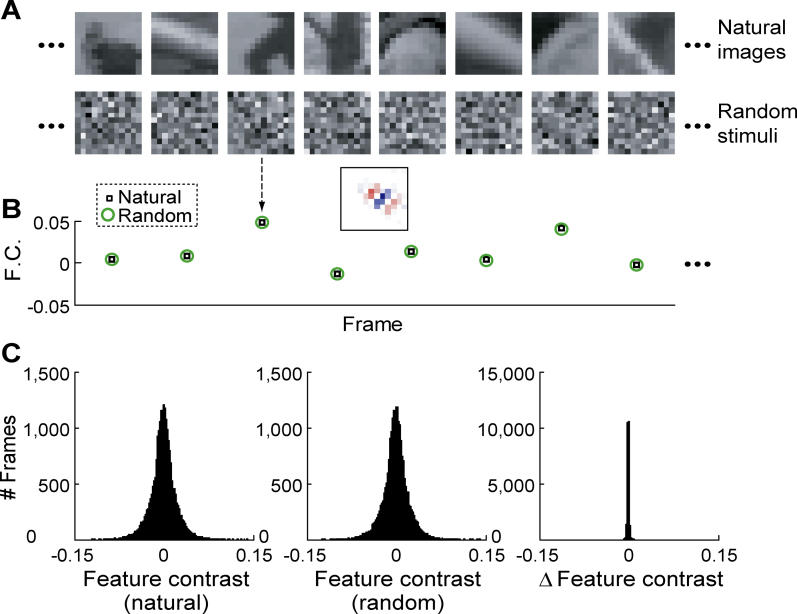
Matching of Feature Contrasts in Natural and Random Ensembles(A) Example images in the natural (upper row) and the random (lower row) ensembles, which were matched frame by frame for both global and feature contrasts.(B) Contrasts of a preferred feature of a complex cell (inset at center) in each frame of the natural (squares) and random (circles) ensembles in (A). F.C. denotes feature contrast.(C) Distributions of feature contrasts in the natural (left) and random (middle) ensembles, and the distribution of the difference in feature contrast between the two ensembles (right).